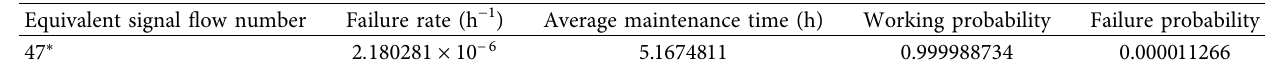
Table 10: Reliability parameters of operator 47 ∗ .